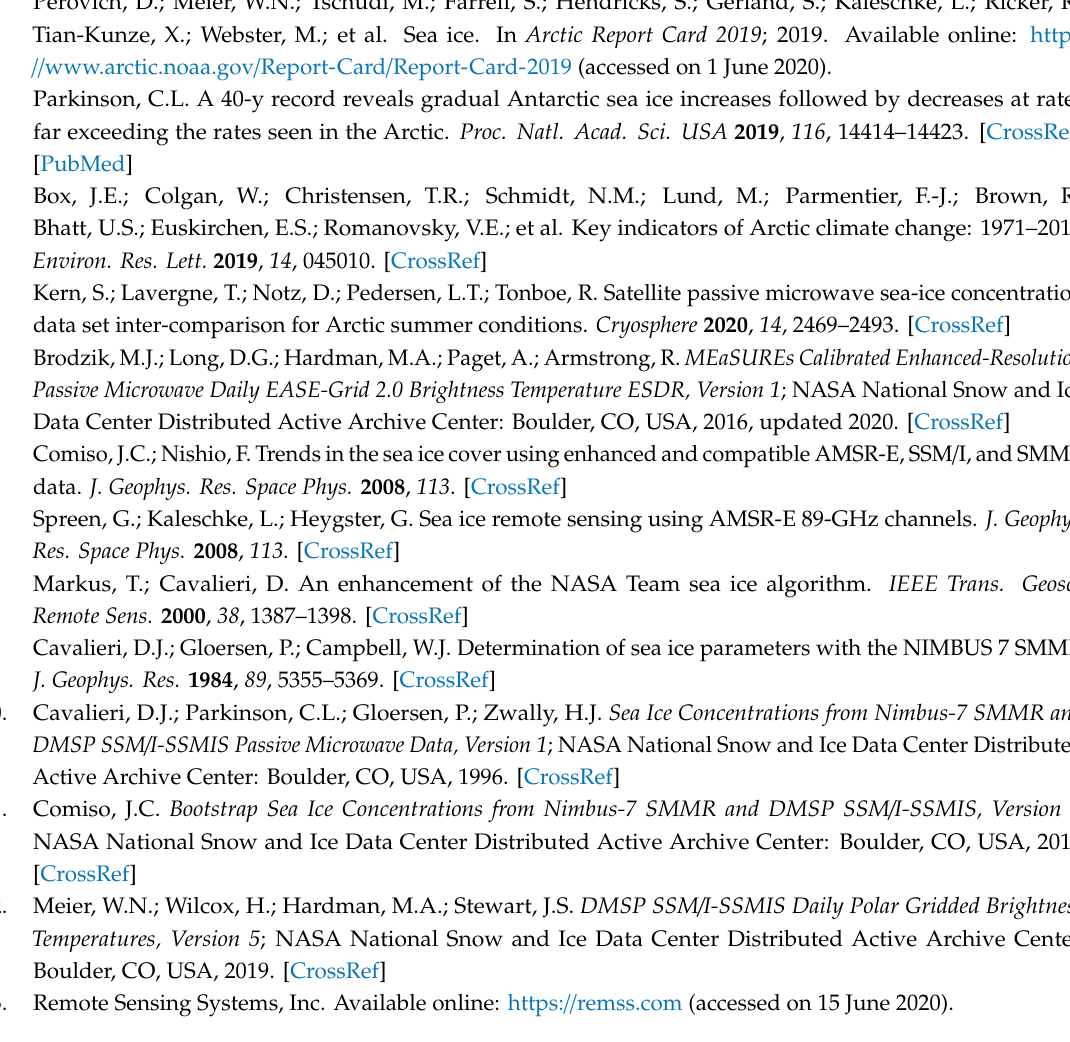
Figure S1: comparison of land mask, Figure S2: 25 km GRD and 3.125 bi-linearly interpolated GRD, Figure S3: MODIS images zoomed in region of thin ice, Figure S4: land-to-ocean transect for 37